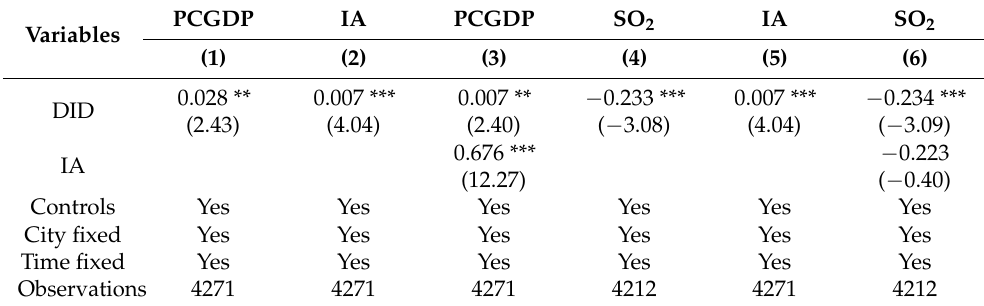
Table 11. Mediating effect of